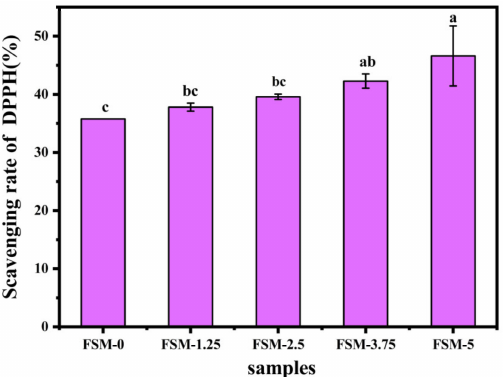
Figure 5. DPPH free radical scavenging activities of composite